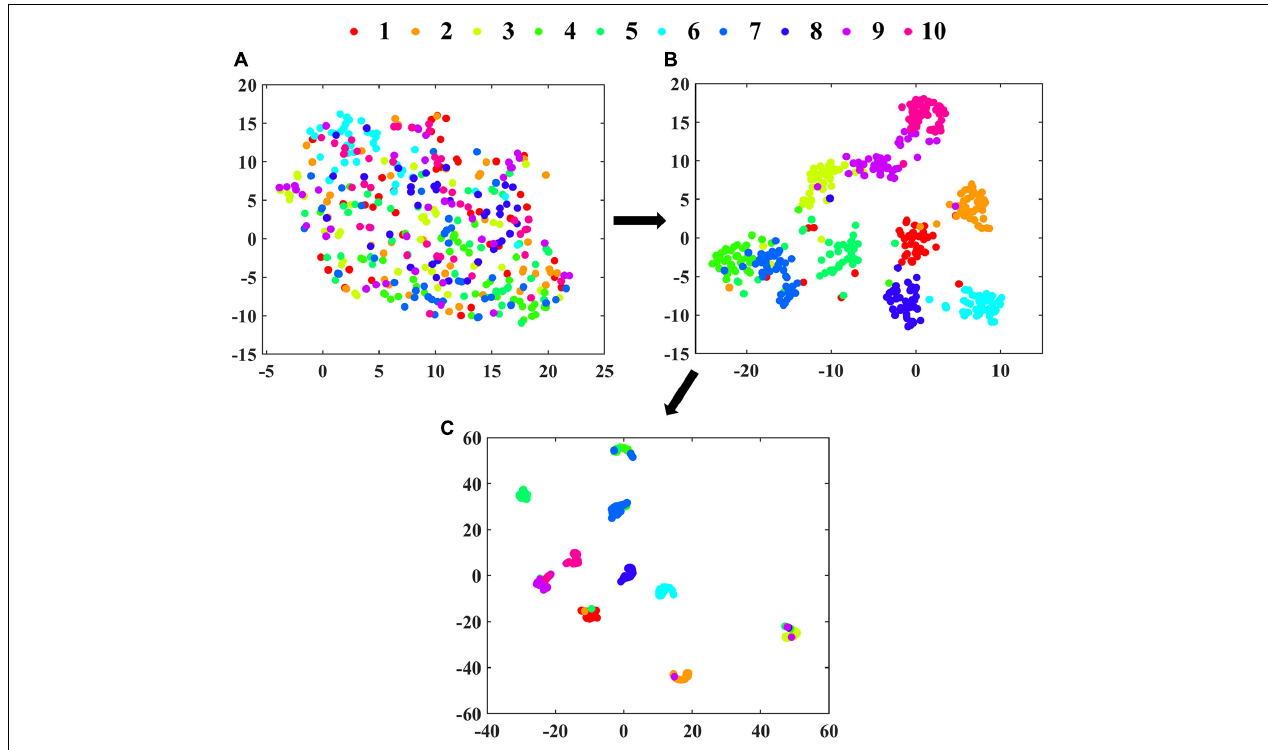
FIGURE 6 | The visualization of clustering effects in layers of (A) Max pooling, (B) RES. Block4 and (C) Dense 10 in 2D-PCSA ResNet by t-SNE.